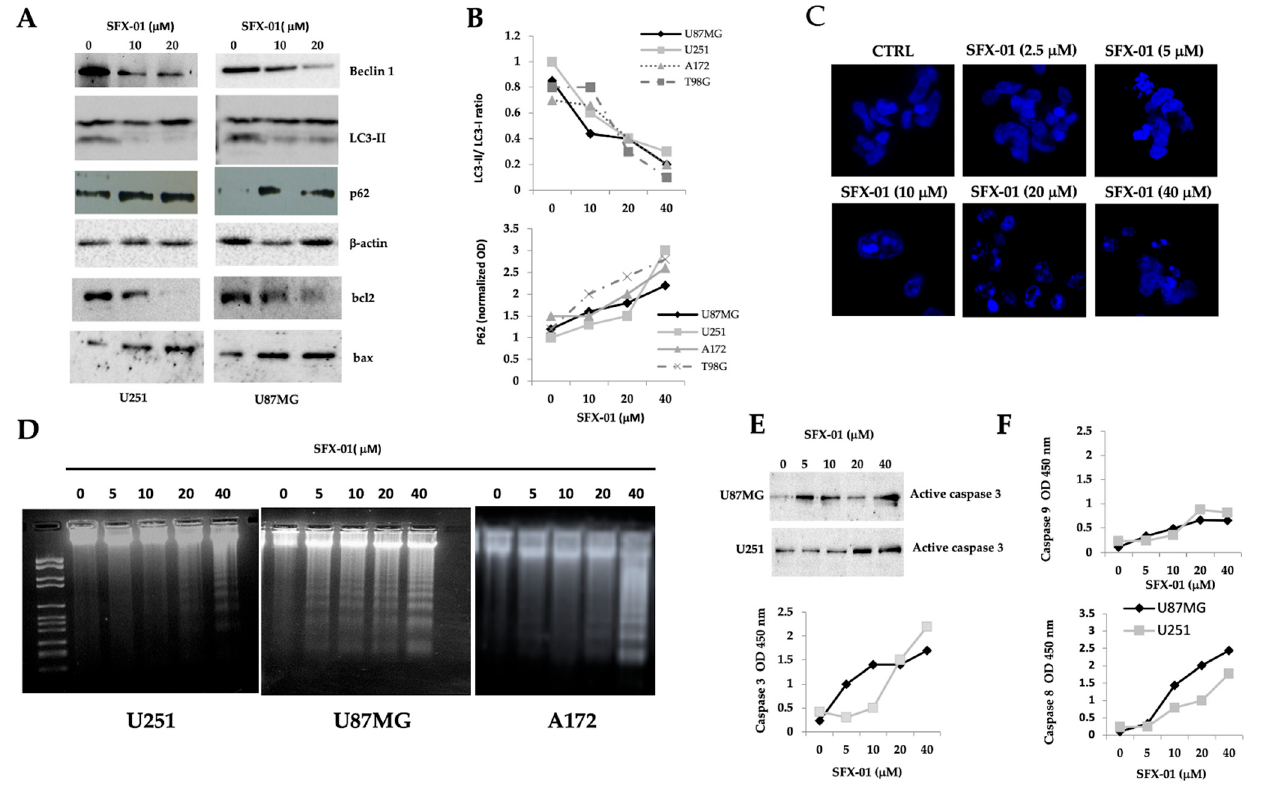
Figure 6. SFX-01 reduced basal autophagy and induced apoptosis in GBM cell lines: ( A ) Beclin-1, LC3, P62, Bcl2, and Bax expression according to Western blots, performed on U87Mg and U251 cell extracts. A total of 40 µg of proteins per lane were loaded. To quantify autophagy, Western blots were repeated three times and each band was analyzed using the ImageJ software (v. 1.8.0). LC3-II and LC3-I bands were normalized to β -actin before calculation of LC3-II and LC3-I ratio values. ( B ) LC3-II/LC3-I ratios determined from Western blots for U87MG, U251, T98G, and A172 cells. ( C ) Morphological changes in U87MG nuclei stained with DAPI for control cells and cells treated with different SFX-01 doses. ( D ) DNA laddering performed for DNA extracted from U251, U87MG, and A172 cell lines, control and treated with 5, 10, 20, and 40 µM SFX-01. ( E ) Western blots and enzymatic assay performed on U87MG and U251 cell lysates showing caspase-3 activation (cleaved caspase-3 identification), as well as quantification of caspase-3 activity by EIA assay for caspase-3. Differences were statistically significant with p < 0.005 since SD was <15% of mean value (F) Quantification of activity of caspase-8 and caspase-9 by EIA determinations. Differences were statistically significant with p < 0.005 since SD was <15% of mean value. 2.6. In Vivo Administration of SFX-01 in U87MG and T98G Subcutaneous Xenografts To determine the potential therapeutic efficacy of SFX-01 in vivo, two subcutaneous xenograft models with methylated MGMT (U87MG) and non-methylated MGMT (T98G) were used. These cells were injected subcutaneously into athymic female cd1 nu/nu mice (2 tumors/animal; total of 5 animals/group). When the tumors were easily measurable (about 100 mm 3 in volume), the mice were randomly assigned as controls (vehicle; Group 1) or SFX-01 treated (SFX-01 at 7.7 mg/kg/day PO; Group 2). Tumor growth was monitored as described in the Materials and Methods section. Overall, SFX-01 alone was well-toler- ated, and the animals appeared healthy, with no clinical signs of distress or local/systemic toxicity. In Figure 7, as well as in Table I, we demonstrate that SFX-01 possessed antitumor ability when used in GBM xenograft models. Panels A and E of Figure 7 show representa- tive images for U87MG xenografts (five harvested tissues). In particular, the reduction of tumor weight was 63.5% (400 mg ± 21 mg versus 1095 mg ± 111 mg of controls) for U87MG xenografts and 55% (268 mg ± 16 mg vs. 819 mg ± 65 mg of controls) for the T98G model.